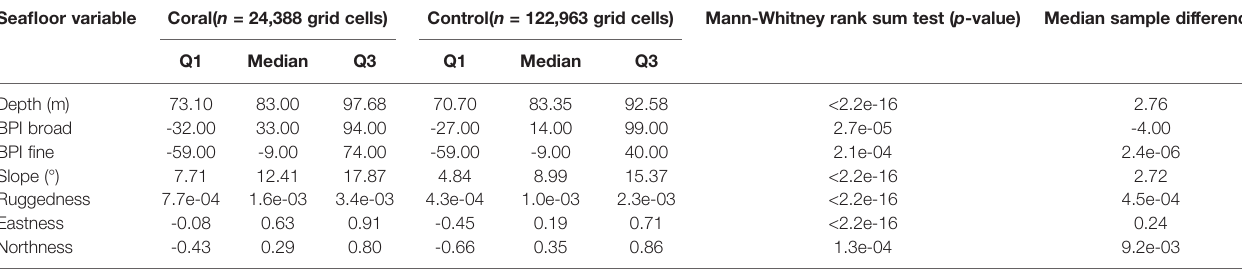
TABLE 5 | Geomorphometric comparison of coral and non-coral (control) regions on the Tautra Ridge. Sea fl oor variable Coral( n = 24,388 grid cells)